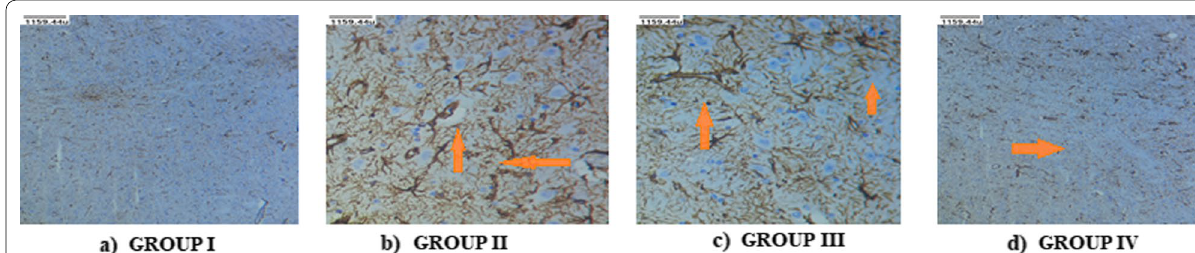
Fig. 6 Representative photomicrographs of GFAP expression on dorsal hippocampus of rats received ICV infusions of PBS or PPA for 7 days. a GROUP I rat brain, b GROUP II rat brain, c GROUP III rat brain, d GROUP IV rat